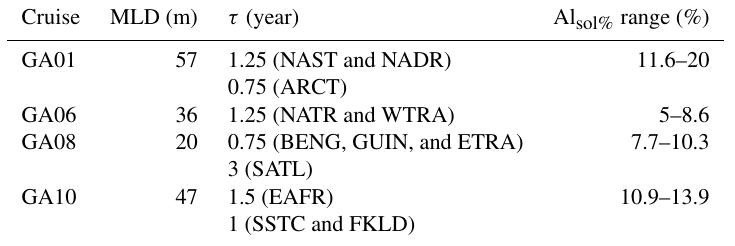
Table 1. Input values to estimate total atmospheric deposition fluxes using the MADCOW model. MLD, average between the median MLDms and MLDar; τ , Al residence time derived from Han et al. (2008) for the different biogeochemical provinces; Al sol% , Al fractional solubility percentage calculated from Baker et al. (2013). For reference to the biogeochemical provinces please refer to Table S1.